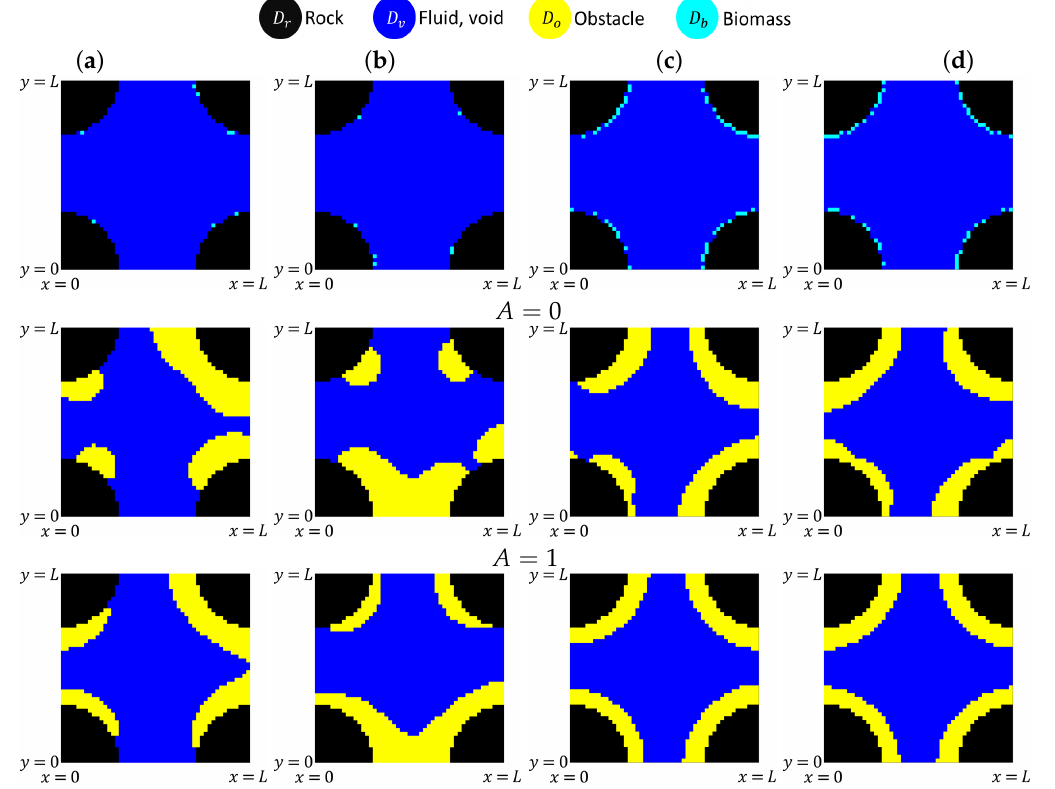
Figure 8. Generation of D o with DNS for single-pore geometry M = 50 × 50, with simulation parameters for cases ( a – d ) are given in Table 2. Top row: randomly chosen regions D relative volume V b = 0.0045 in ( a , b ) and larger volume V b = 0.03 in ( c , d ). Middle and bottom rows: regions D with BN model at the time t ( i ) when the corresponding obstruction volume V o ( t ( i ) ) = 0.3; each region was obtained by simulation with initial conditions shown in the top row, respectively. Smaller V b and A = 0 corresponds to less pronounced coating